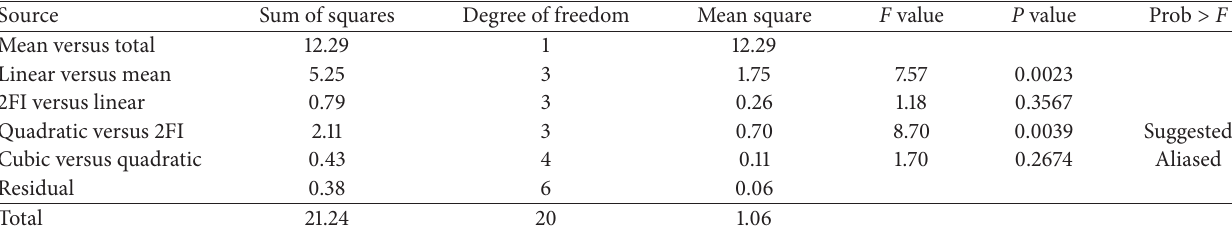
Table 3: Model fit summary for the growth.